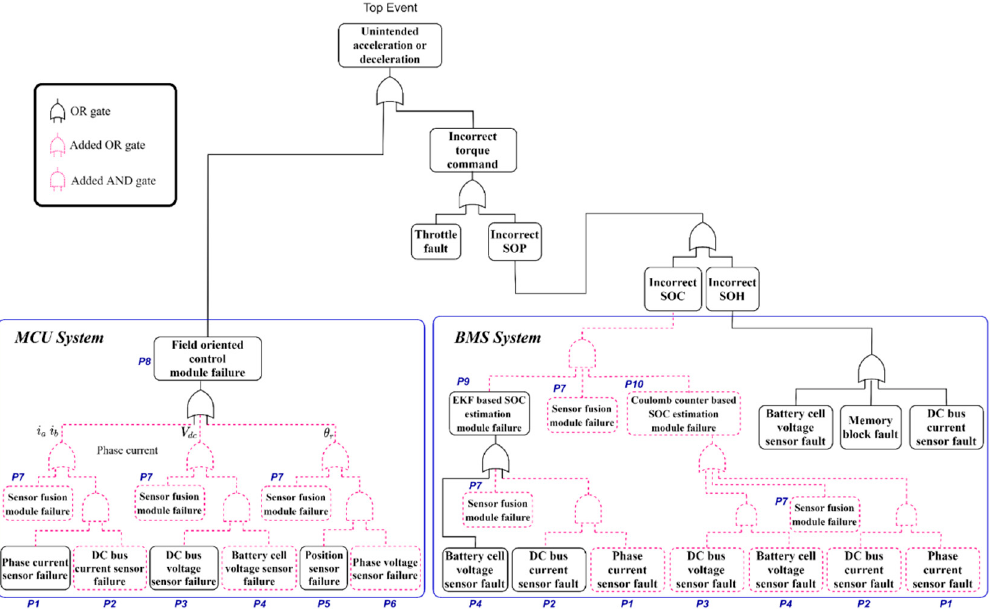
Figure 2. Fault tree analysis of a proposed architecture.